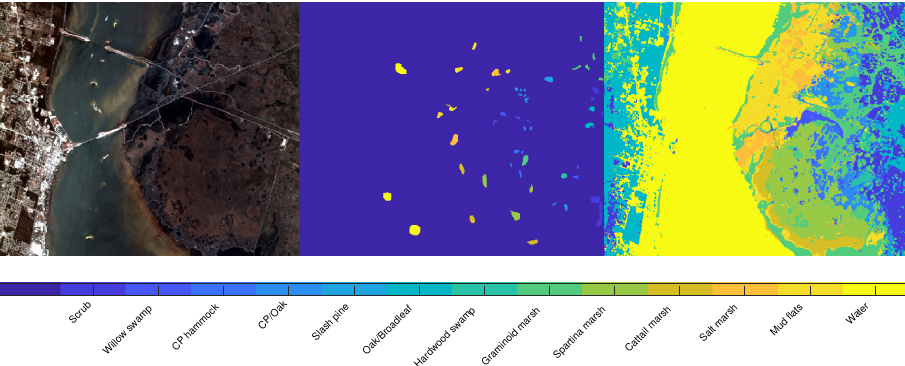
Figure 8. Segmentation results on the KSC dataset. From left to right: false color image, ground truth labels employed as seeds, and segmentation result. On the bottom of the images the legend associates the color to the labels.